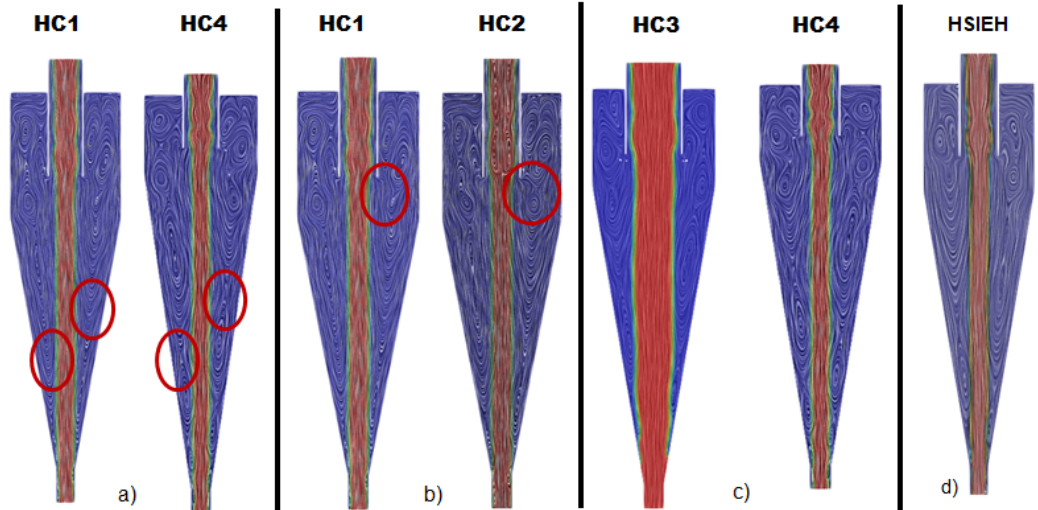
Figure 11. Representation of saddle point and vortical structures for efficient hydrocyclones, ( a ) comparison flow pattern between HC1 and HC4, ( b ) comparison flow pattern between HC1 and HC2, ( c ) comparison flow pattern between HC3 and HC4, ( d ) HSIEH flow pattern.